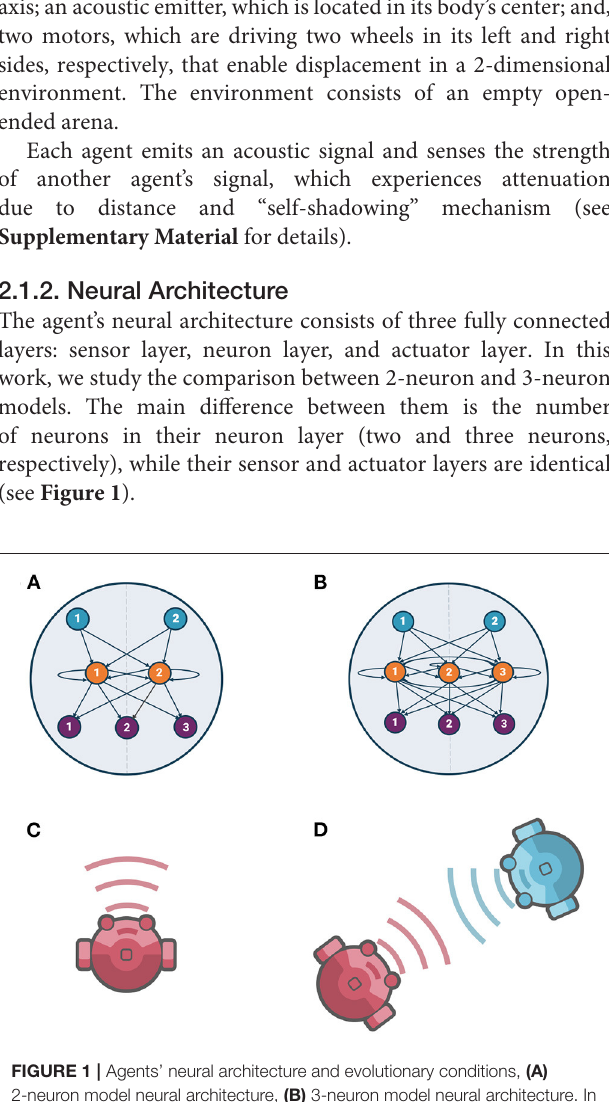
Frontiers in Neurorobotics |